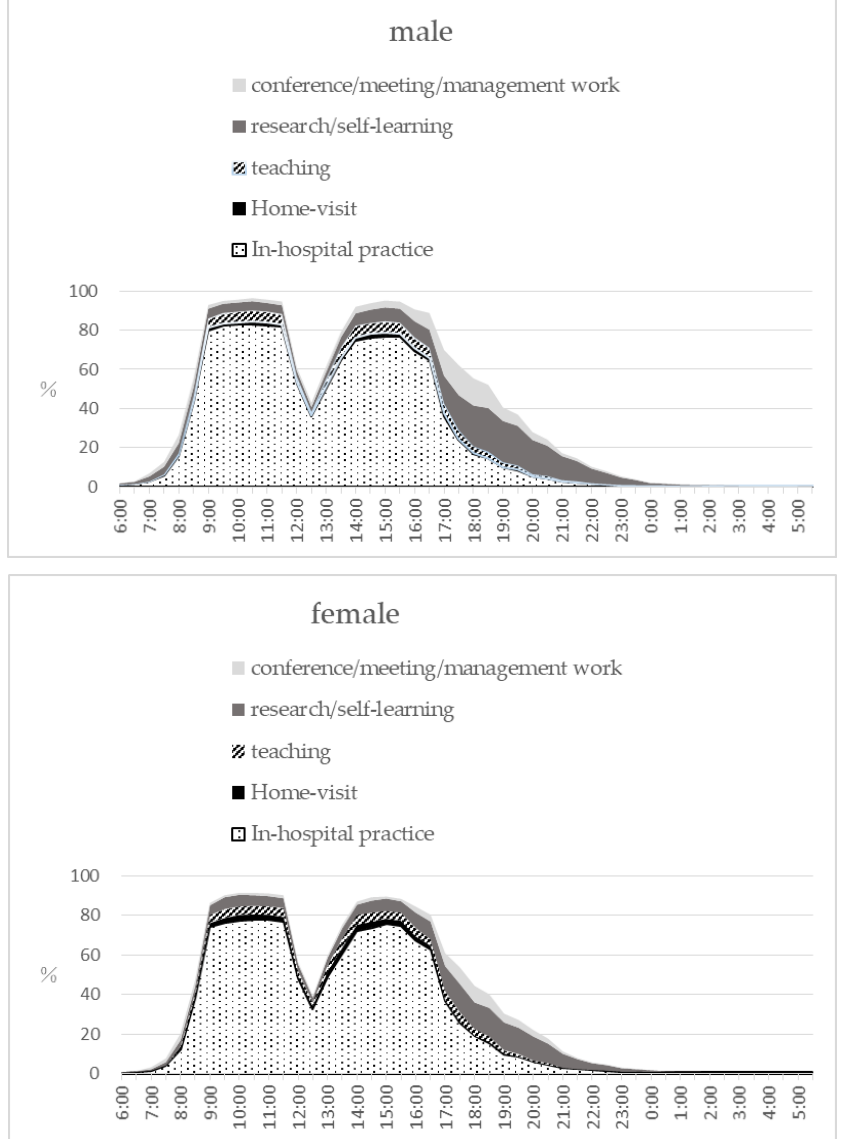
Figure 1. The percentage of engaged duties for 24 h among hospital dentists by gender.